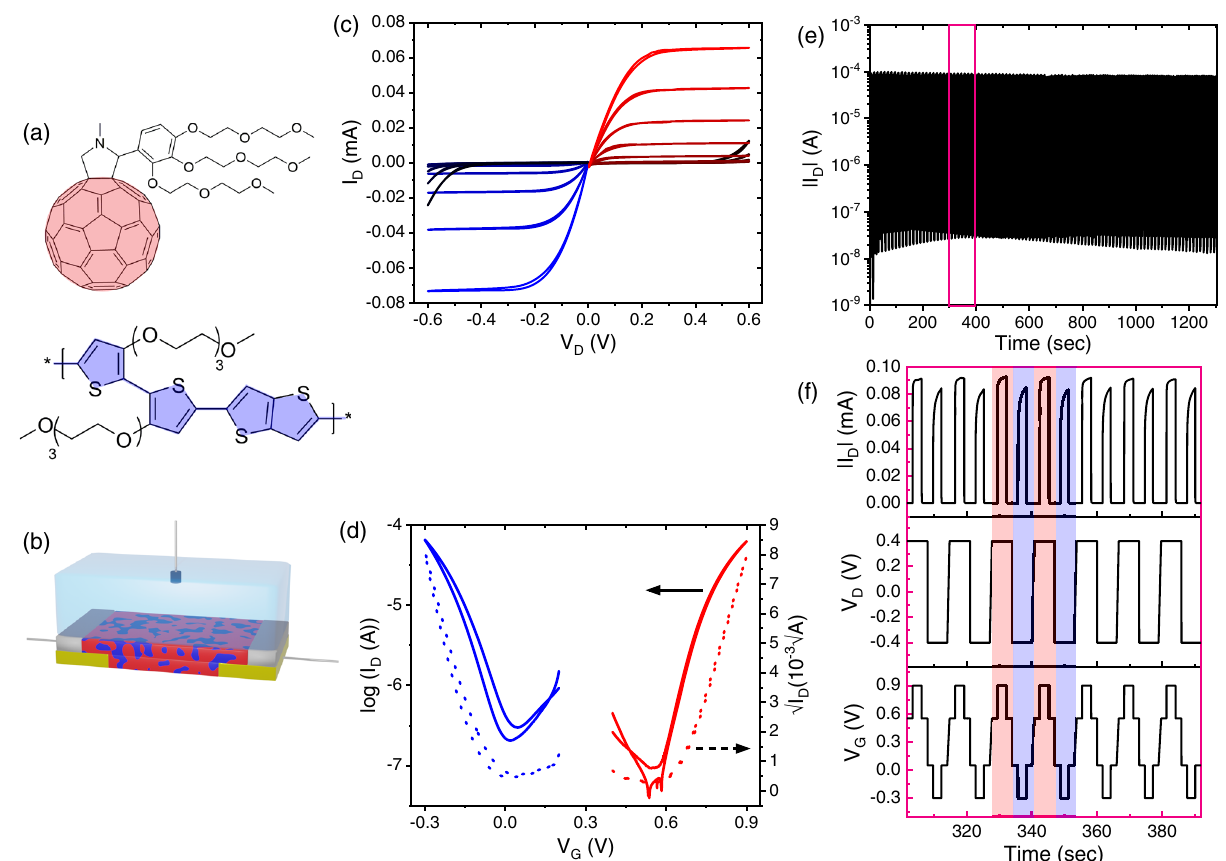
Fig. 1 | Materials, device characteristics, and long-term stability operation. a Chemicalstructuresofthematerialsusedinthisstudy:n-typefullerenederivative PrC 60 MA (top,red)and the p-typepolymer p(g2T-TT)(bottom, blue). b Schematic of the OECT device with 3-terminals (Au source and drain, Ag/AgCl pellet gate), using a PrC 60 MA:p(g2T-TT) blend as the active channel in a 0.1M KCl aqueous electrolyte. c Output characteristics (I D -V D ) of the ambipolar device (length (L)=30 μ m ,width(W)=1000 μ m ,thickness( d )=60nm)forV G varyingfrom+0.2V to − 0.3V at the p-type (black to blue curves in bottom left quadrant) and from +0.4Vto+0.9Vatthen-type(blacktoredcurvesintoprightquadrant)withastep